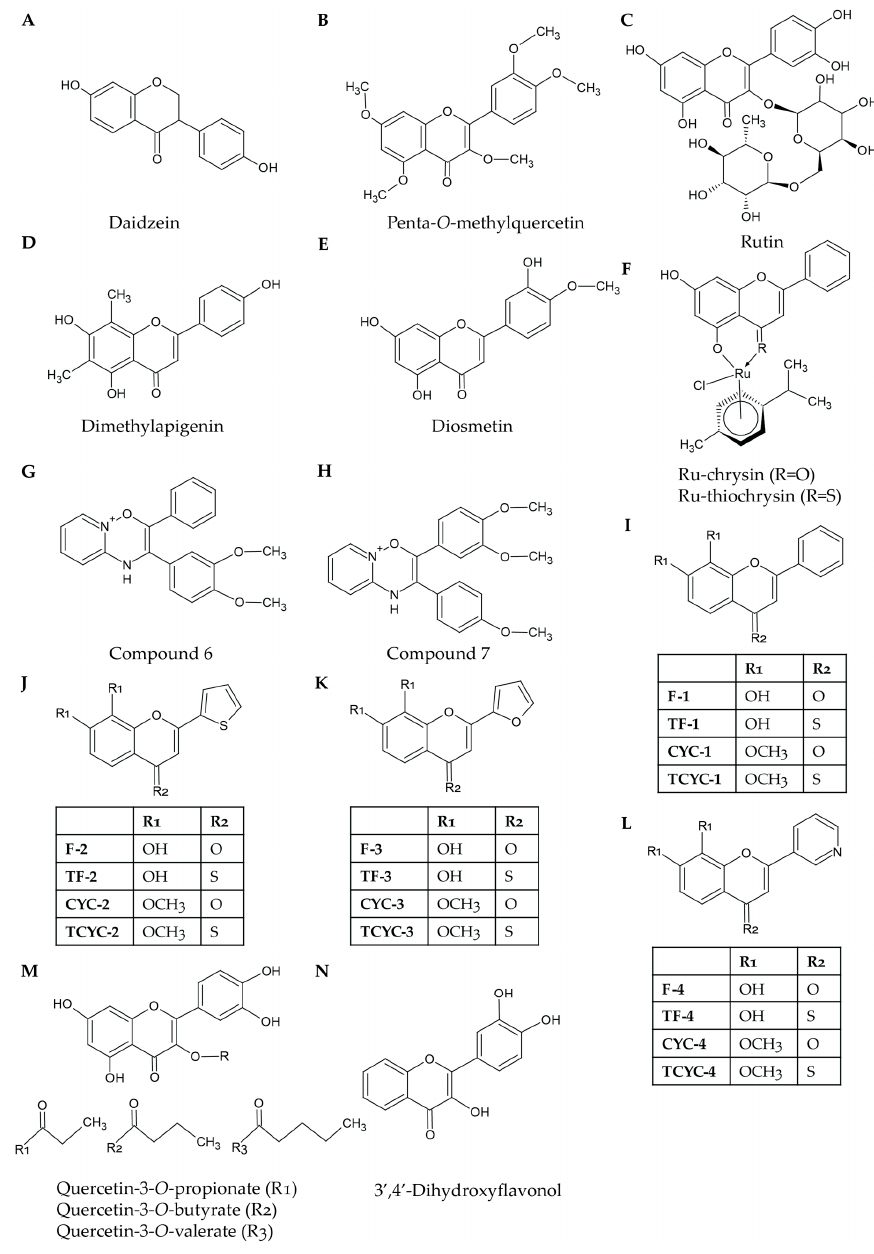
Figure 2. Structures of selected natural and synthetic flavonoids: Daidzein ( A ) is the flavonoid from which equol is derived. Penta- O -methylquercetin ( B ) has a similar structure to quercetin; however, all of its hydroxyl groups have been methylated. Like rhoifolin, rutin ( C ) also has a glycosidic bond; however, in this compound, it is connected at C3 as opposed to C7. Dimethylapigenin ( D ) is structurally similar to apigenin; however, it possesses two methyl groups at the C6 and C8 positions. Diosmetin ( E ) and luteolin have similar structures; however, the 4 (cid:48) -hydroxyl group in luteolin has been replaced with a methoxy group in diosmetin. Ru-chrysin and Ru-thiochrysin ( F ) share the same structure as chrysin; however, they have been conjugated to ruthenium. The two compounds di ff er due to the substitution of a carbonyl group with a thiol group attached to C4. Compound 6 ( G ) and compound 7 ( H ) are pyrido(1,2- a )pyrimidin-4-one analogues that possess methoxylated phenyl groups attached to C2 and C3. Ravishankar et al. [35] developed hydroxylated or methoxylated synthetic flavonoids with modified B-rings. The B-rings could be either phenyl groups ( I ), thiofuran groups ( J ), furan groups ( K ), or pyridyl groups ( L ). Synthetic modifications of flavonoids can lead to the addition and extension of acyl chains at C3 to molecules such as quercetin ( M ). 3 (cid:48) ,4 (cid:48) -Dihyrdoxyflavonol ( N ) is a synthetic flavonoid based on the structure of a flavonol but with two hydroxyl groups at the C3 (cid:48) and C4 (cid:48)